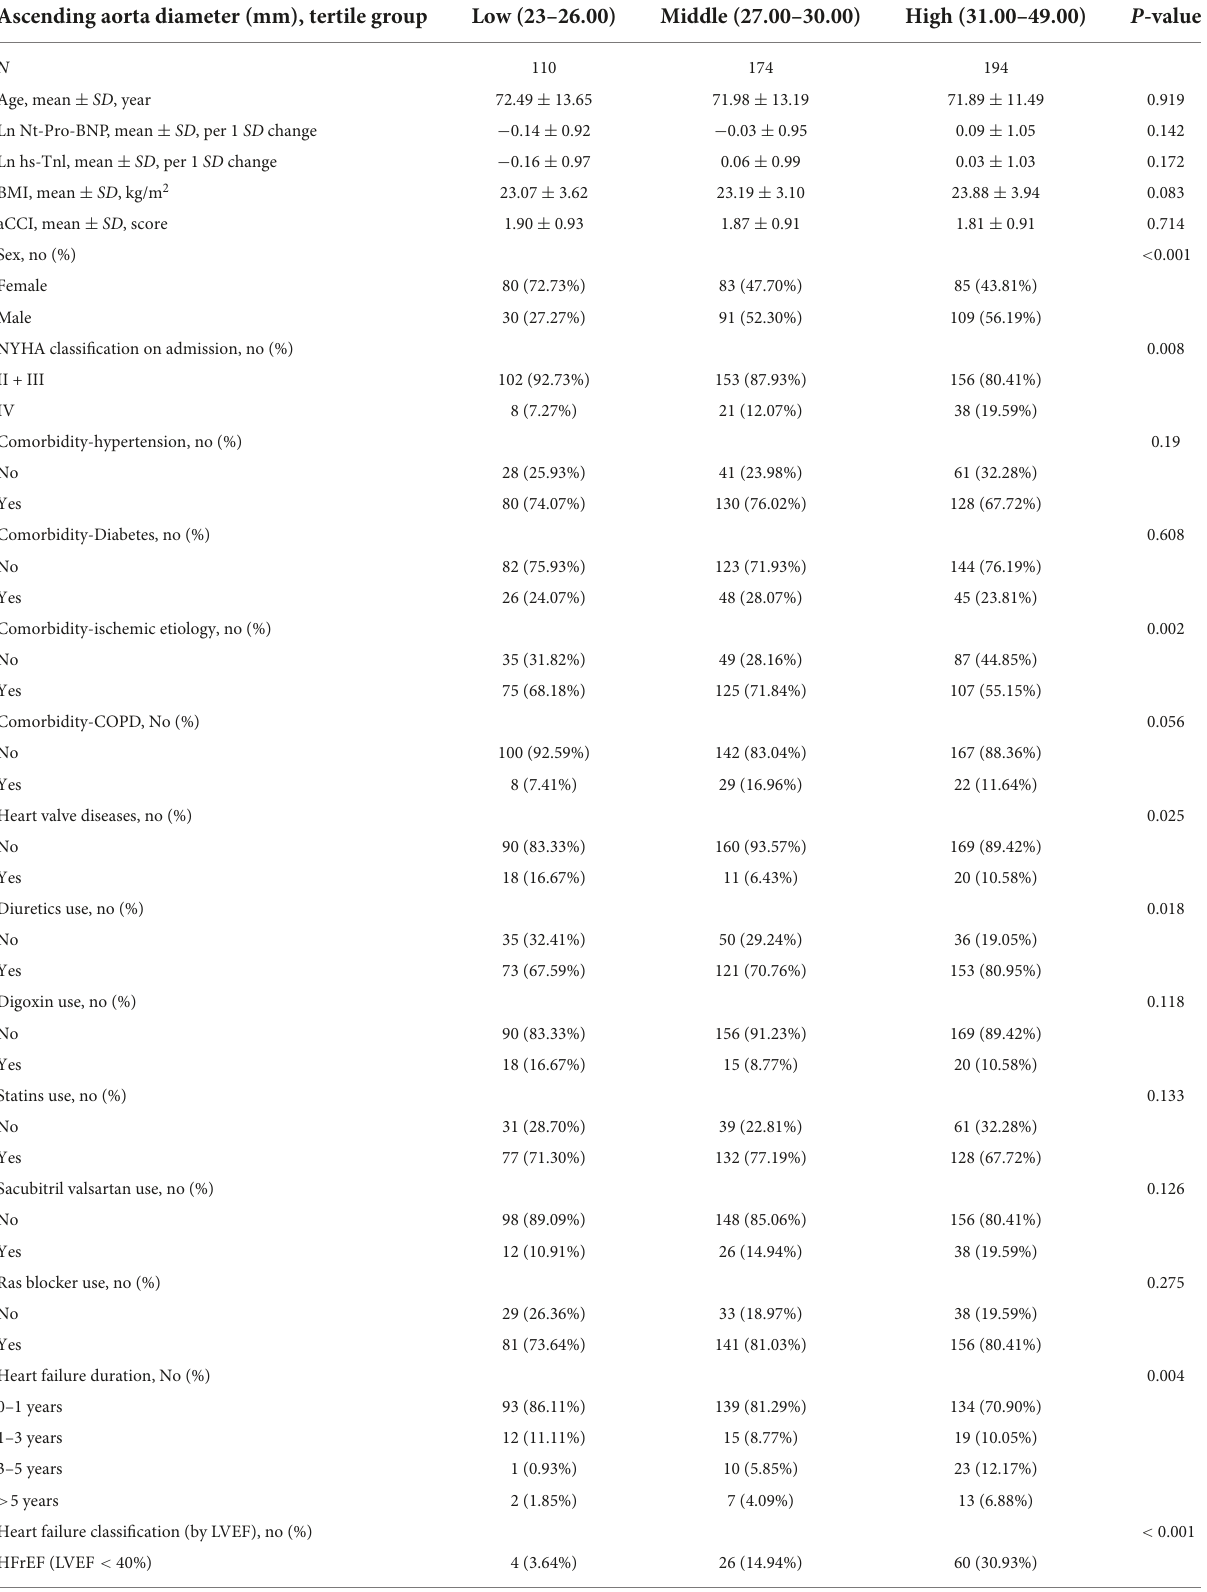
TABLE 1 Baseline characteristics of patients with chronic heart